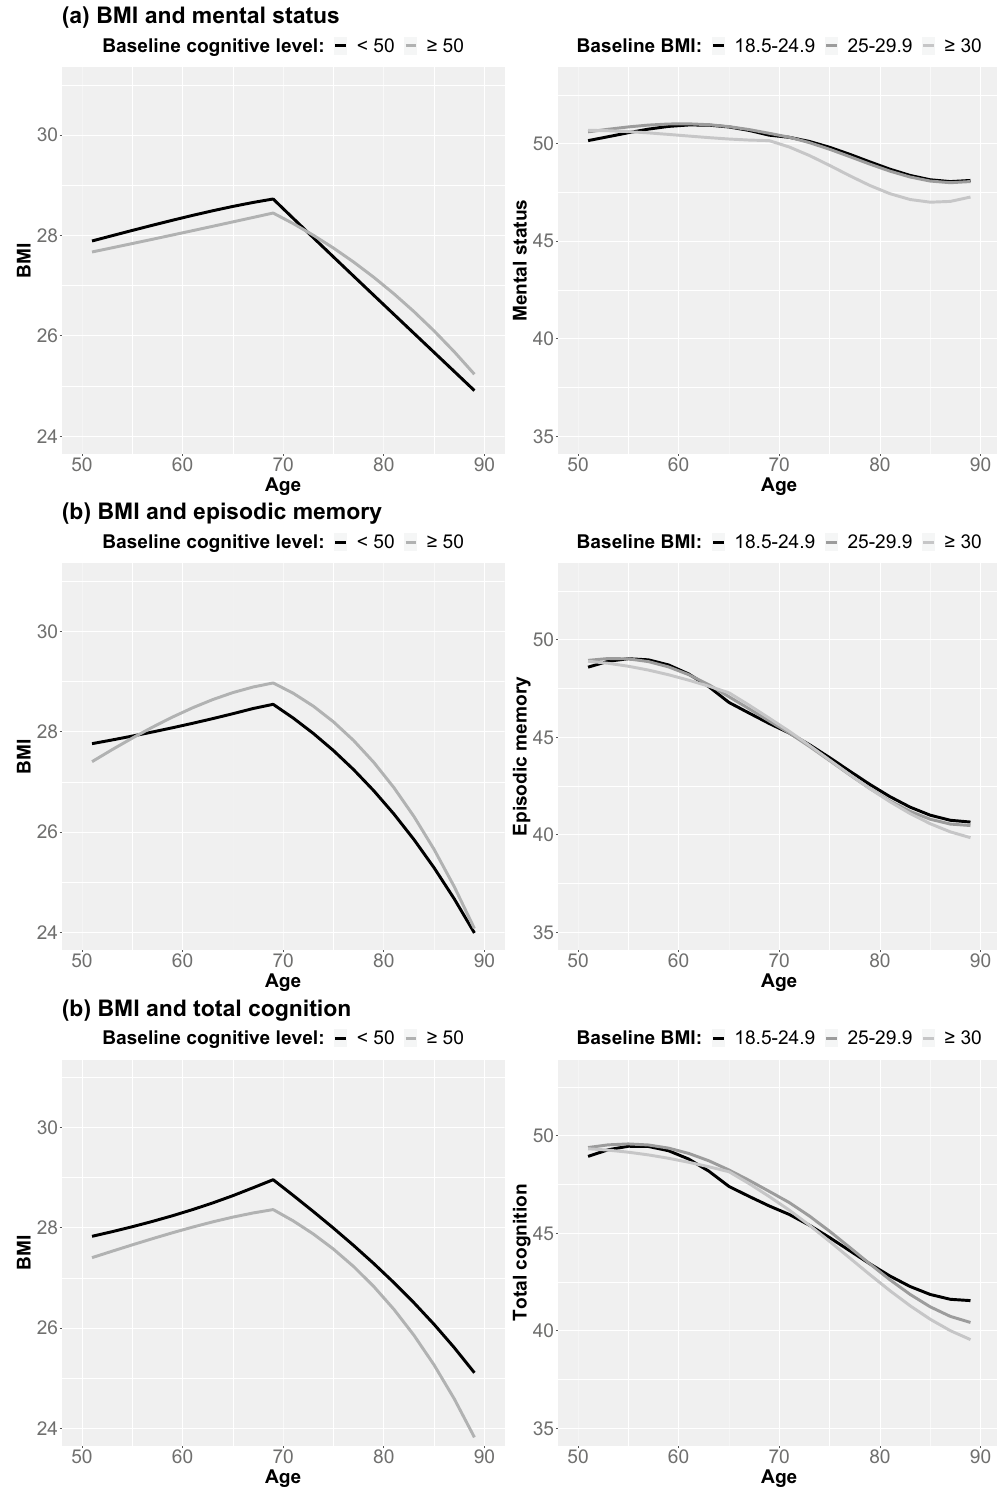
Figure 3. Longitudinal trajectories from bivariate dual change score models, showing change in BMI stratified by cognitive ability level at baseline, and change in cognitive abilities stratified by BMI level at baseline. Models were adjusted for sex and education, and a breakpoint in the proportional change and coupling parameters added at age 70 for BMI and mental status, and at 65 for episodic memory and total